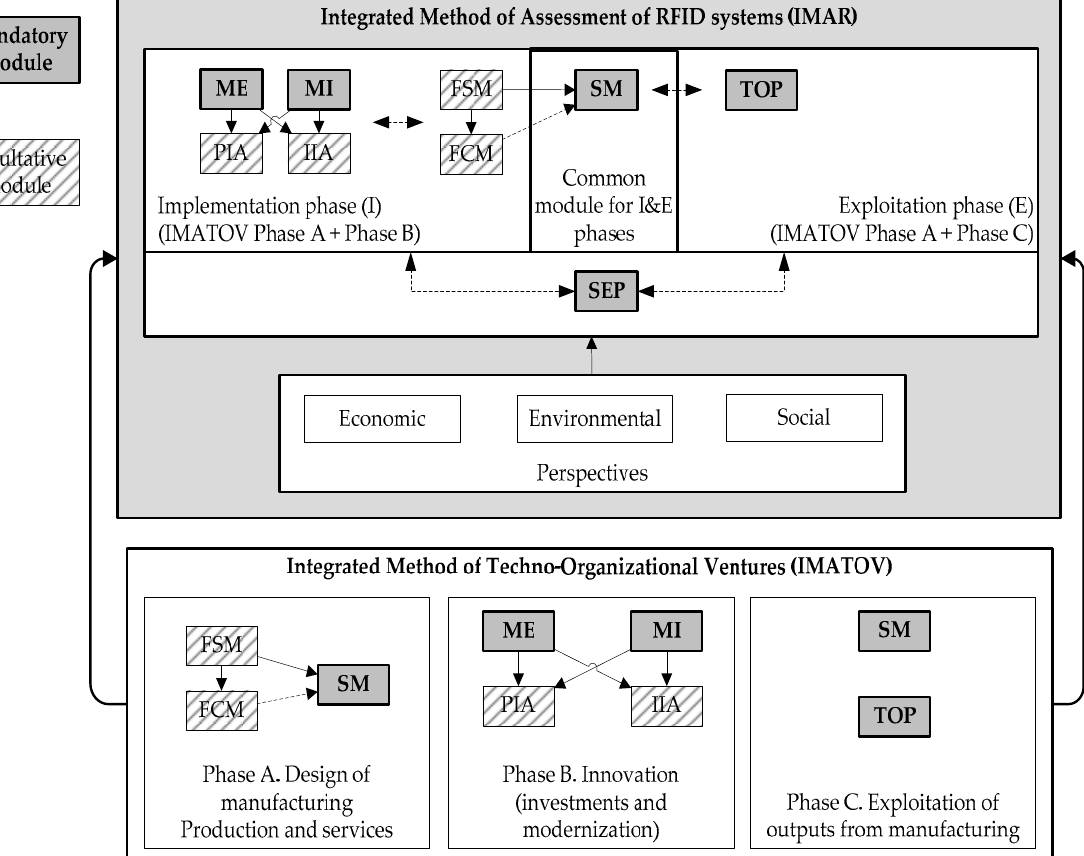
Figure 2. Conventional IMAR modular structure [48].